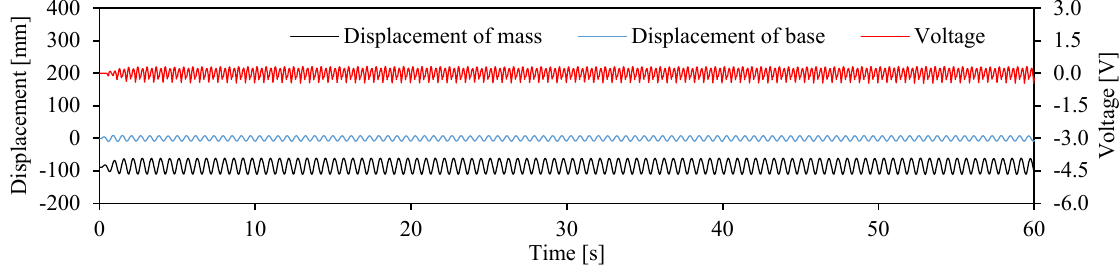
and 5.62 mm, respectively, which resulted in 1.63 mW of power generated. Figure 13. Measurement results for 1.6 Hz periodic signal excitation.